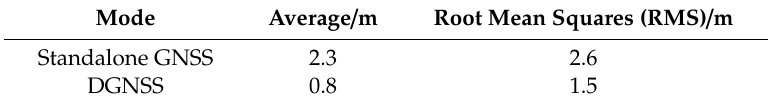
Table 2. Performance comparison between standalone GNSS and DGNSS in the smartphone. Mode Average / m